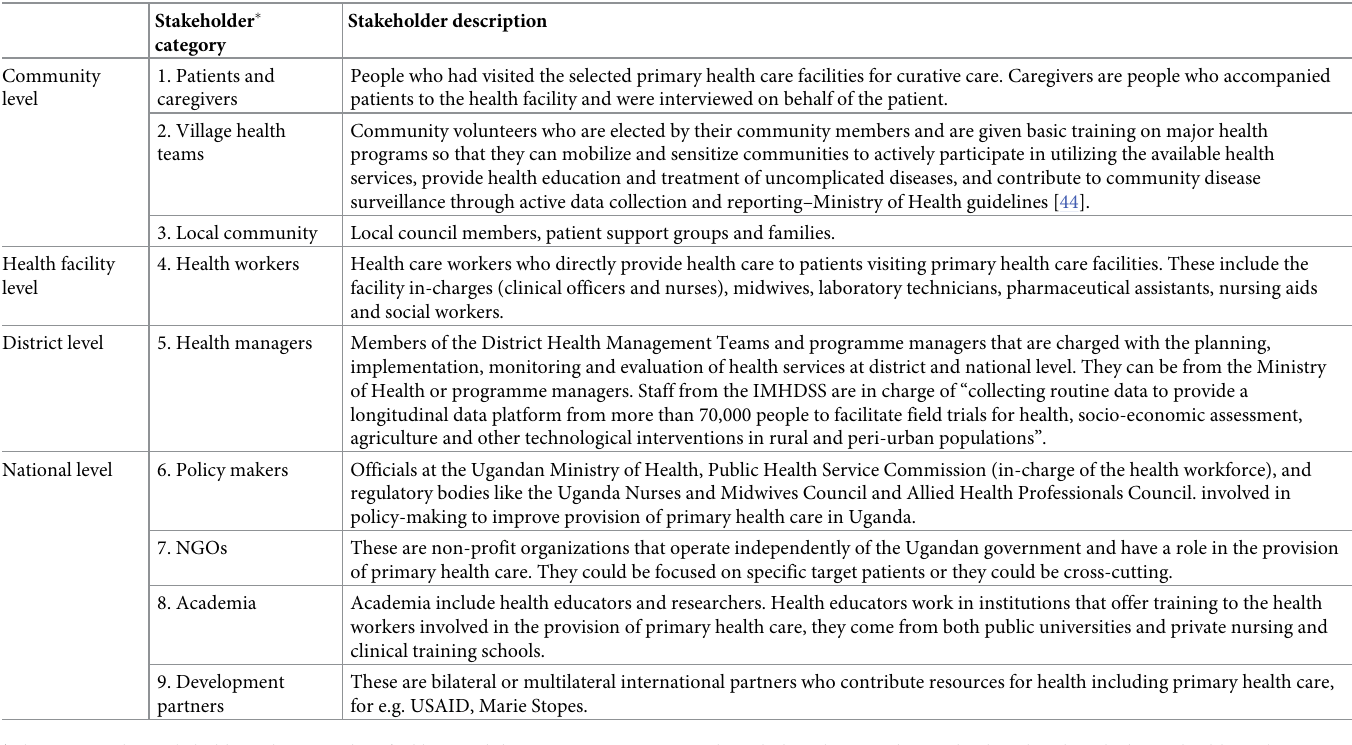
Table 2. List and description of stakeholder